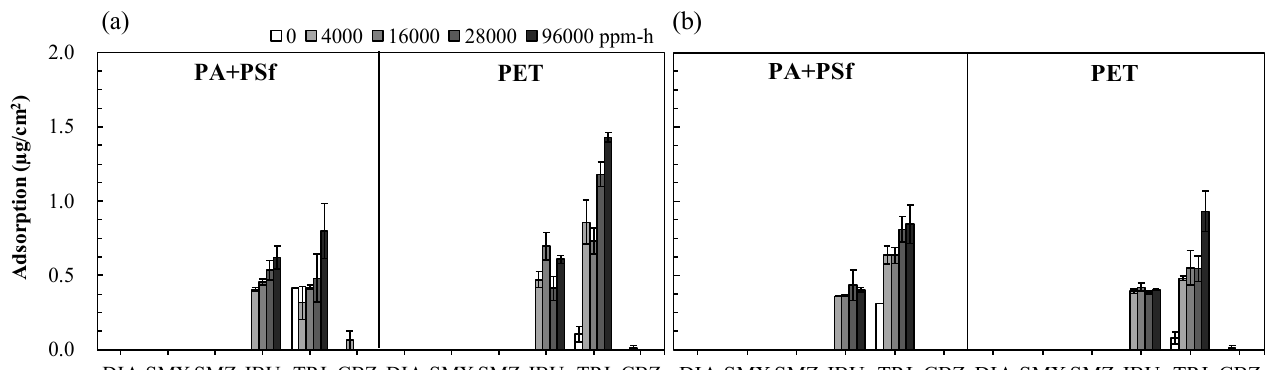
Figure 8. Adsorption of IBU, TRI, and CBZ extracted from PA + PSf and PET layers of ( a ) TFC and ( b ) TFC-GO membranes with the range of 0 − 28,000 ppm-h H 2 O 2 exposure. Error bars represent one standard deviation of triplicate measurements.